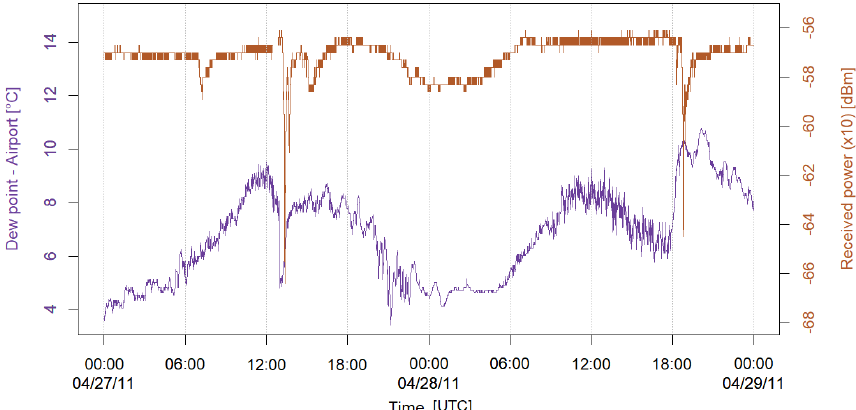
Figure 8. Wet antenna attenuation due to dew formation causes substantial attenuation from approx. 18:00UTC on 27 November 2011 to 07:00UTC on 28 November